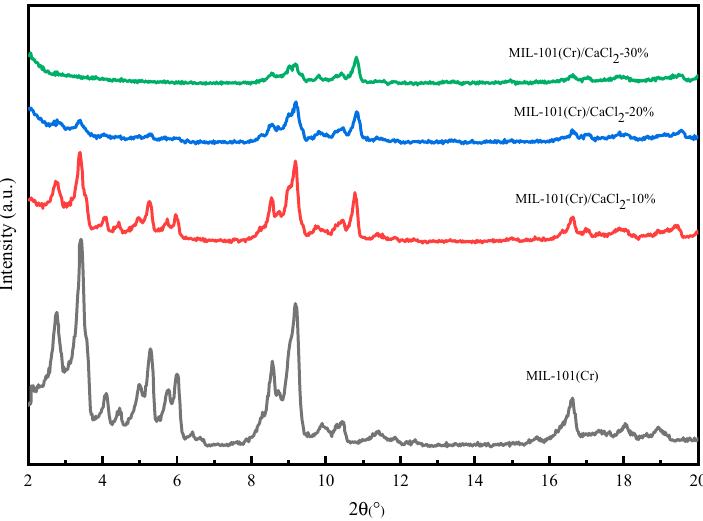
Figure 1. XRD pattern of MIL-101(Cr) and composites.